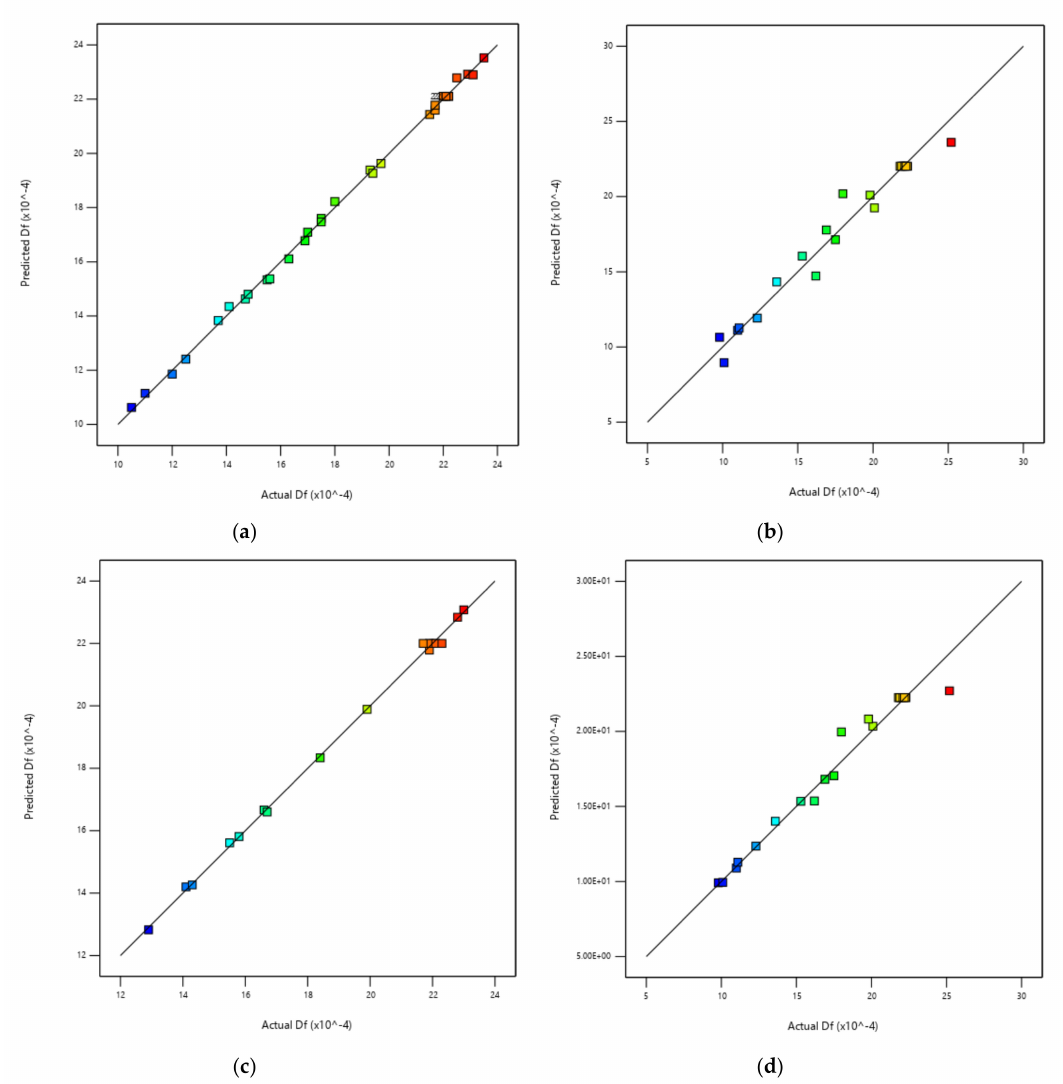
Figure 11. D f predicted vs. D f actual: ( a ) Complete design; ( b ) Central composite design; ( c ) Box–Behnken design; and ( d ) Central composite design with power